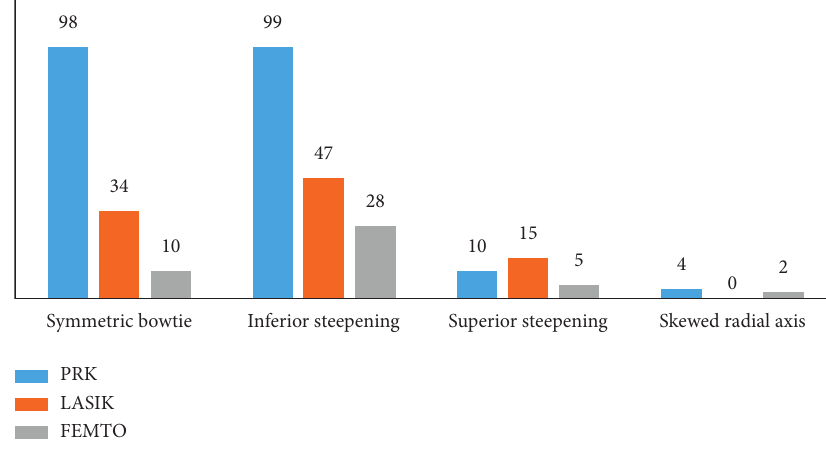
Figure 2: Subgroups of preoperative corneal topographic